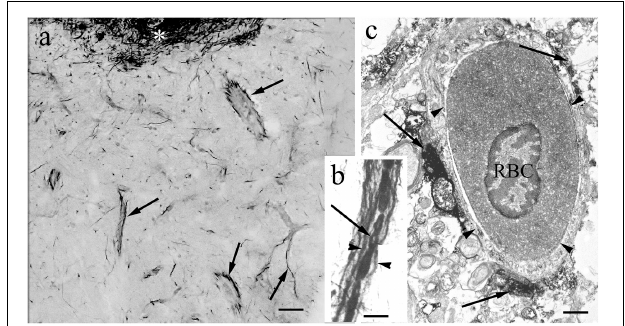
FIGURE 5 | The perivascular glia. In contrast to the other Gnathostomata, in Actinopterygii the perivascular glial processes are not perpendicular to the vessels but course along them. (a) Glial processes (arrows) around vessels (goldfish). Asterisk: periventricular glial plexus. Scale bar: 40 µ m. (b) Glial processes (arrowheads) along a vessel, between them red blood cells. Arrow points to the site of a nucleus devoid of the non-specific peroxidase reaction of hemoglobin (carp). Scale bar: 10 µ m. (c) Electron microscopic cross-section of a vessel (arrowheads). RBC: a red blood cell with nucleus. Arrows: glial processes. (goldfish). Scale bar: 1 µ